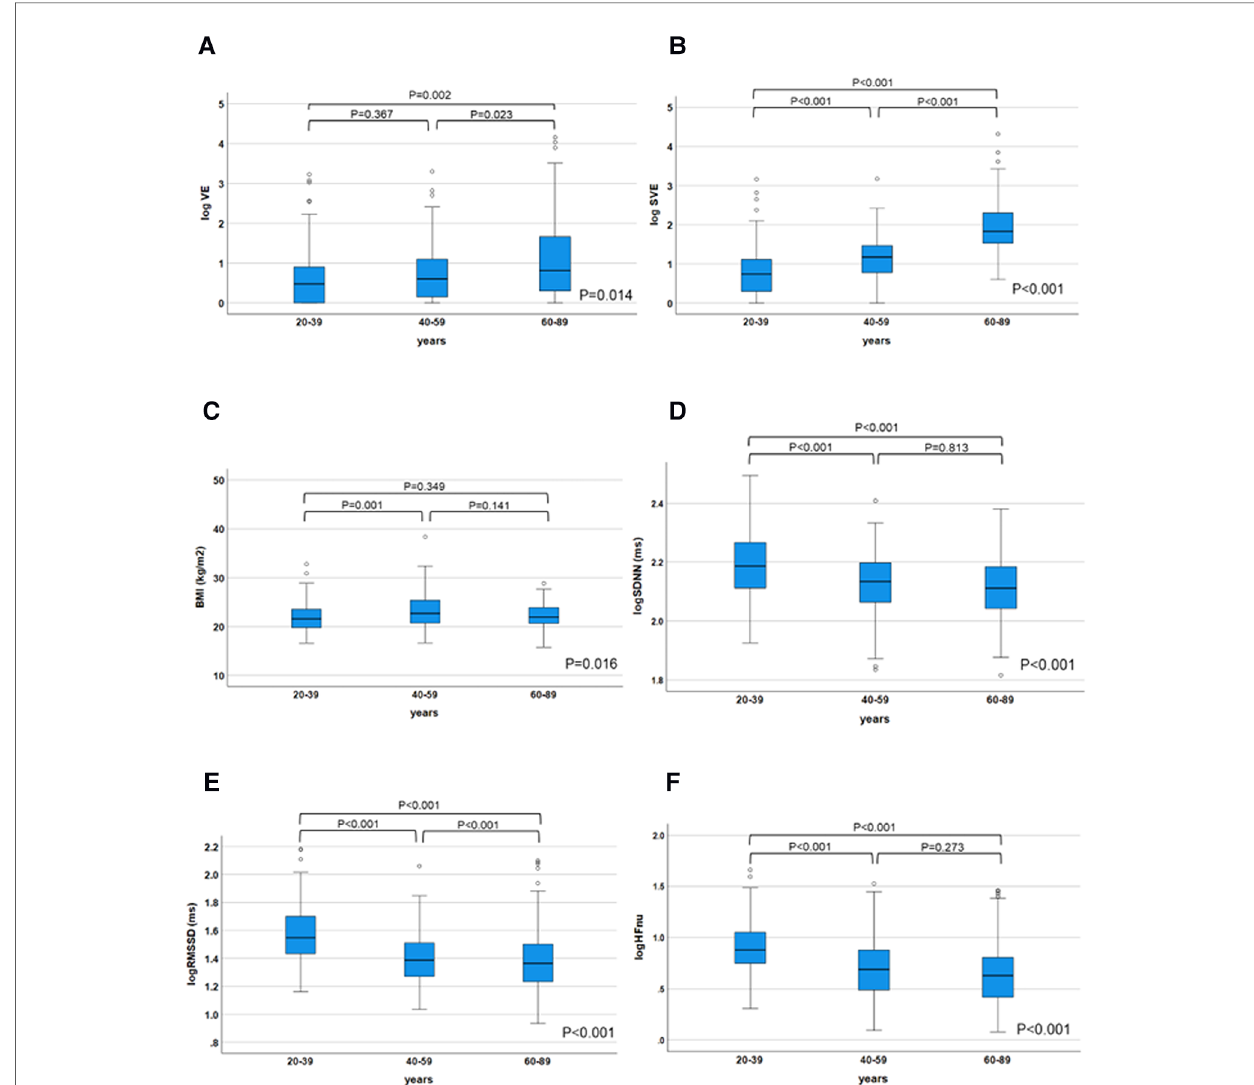
FIGURE 3 Changes in the ectopy prevalence and parameters in fl uencing ectopy prevalence in each generation. The log VE/day and log SVE/day were signi fi cantly decreased in the older generation ( P =0.014 for log VE; P <0.001 for log SVE), ( A ), ( B ). On the other hand, body mass index was signi fi cantly higher in the 40 – 59-year age group than in the 20 – 39- and 60 – 89-year age groups ( P =0.016) ( C ). HRV parameters (log SDNN, log RMSSD, and log HFnu), which in fl uenced the prevalence of SVE, were signi fi cantly decreased in the older generation ( P <0.001 for all, respectively) ( D – F ). The parameters in fl uencing the ectopy prevalence in each generation were compared using the Kruskal – Wallis test; post hoc multiple comparisons were performed using the Bonferroni method. HRV, heart rate variability; SVE, supraventricular ectopy; VE, ventricular